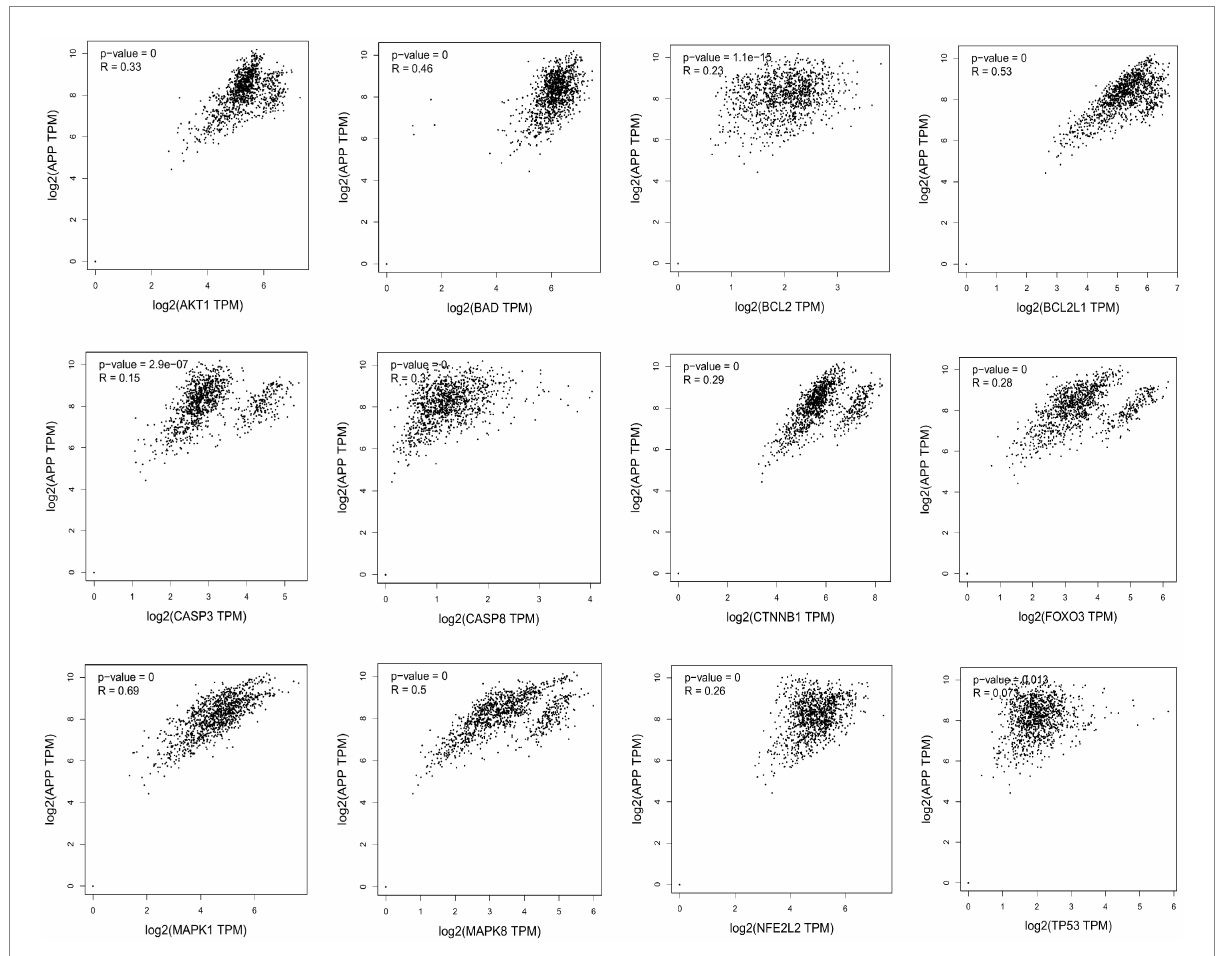
FIGURE 5 Analysis of the correlation between 12 key targets of Cordycepin and the pathogenic gene of Alzheimer’s disease